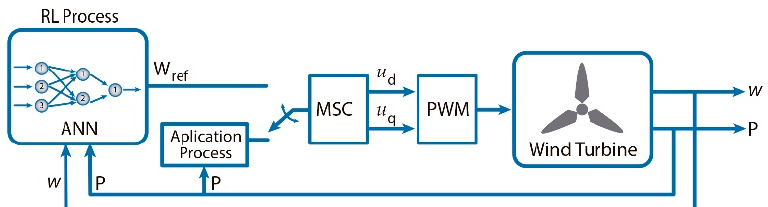
Figure 18. ANN trained by a reinforcement learning (RL) algorithm, the system changes to application mode and returns to learning mode when there are changes in the environment, until it is trained again [77].